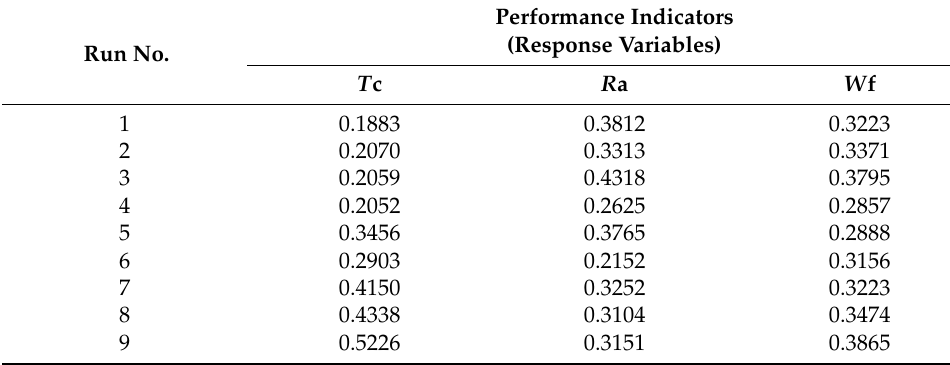
Table 8. Response variables in the form of obtained standardized decision matrix.